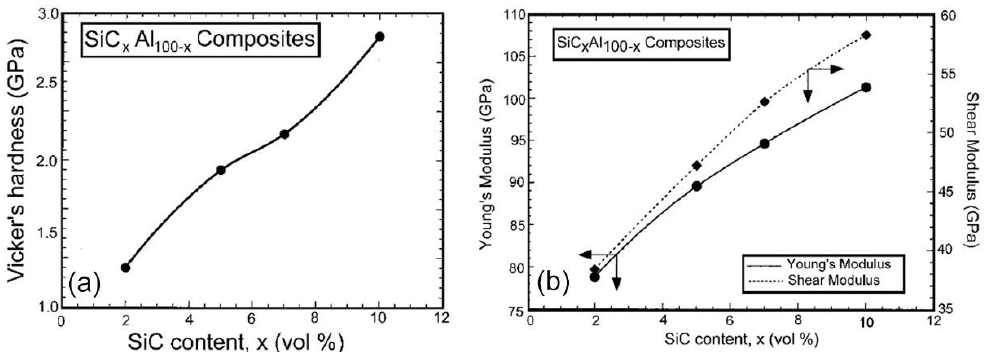
Figure 20. Correlation between the SiC content, x, and the ( a ) Vickers hardness and ( b ) elastic moduli of consolidated SiC x /Al 100-x powders produced after 86 ks ball milling.